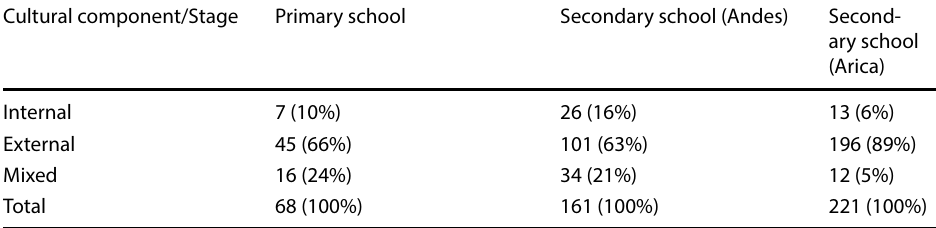
Table 5 Content analysis of SEII test. Frequency and percentage that each cultural component appears in each